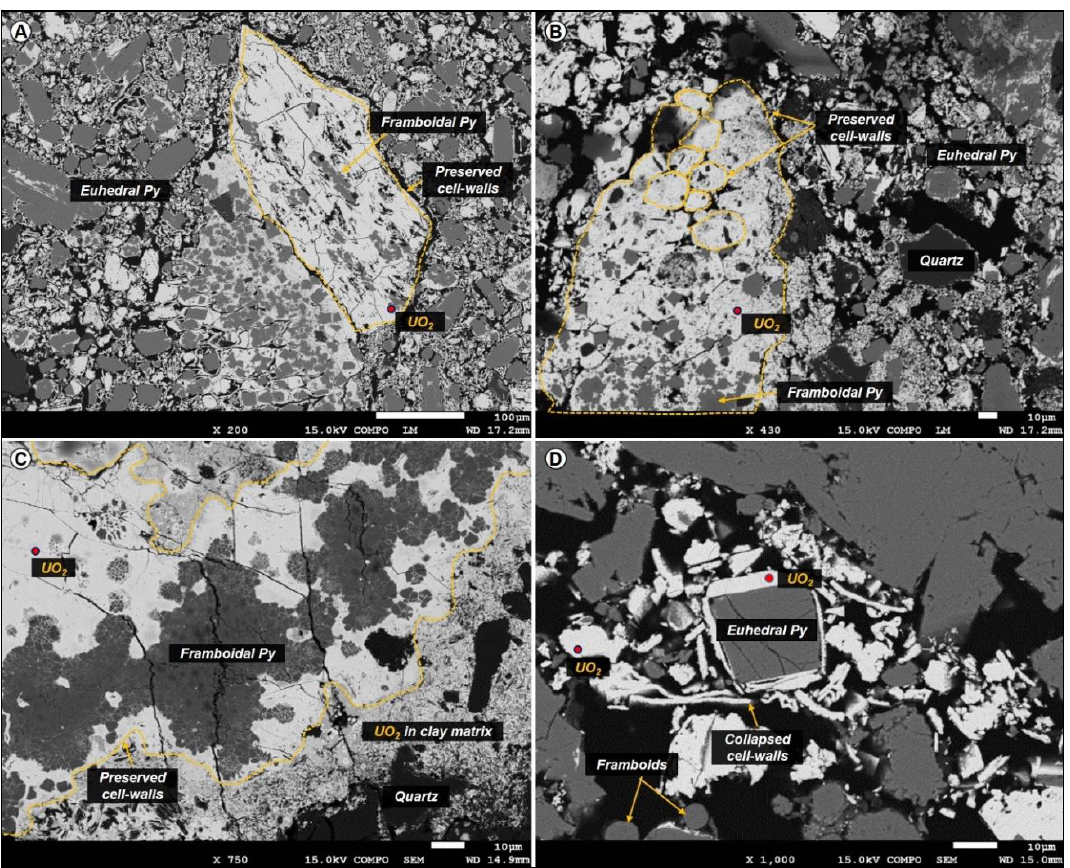
Figure 13. Examples of organic matter replaced by uranium, which is expressed in oxide form at the rims of the organic particle with a composition close to UO 2 stoichiometry (as measured under SEM-EDS mode). ( A ) Telohuminite particle at a size range of 400 μm, with the textural characteristics (cell walls and desiccation cracks) still visible. ( B ) Elongated telohuminite particle composed of smaller epigenetized corpohuminite particles. ( C ) A fully uranium-cemented organic particle associated with framboidal pyrite showing features of corrosion and uranium replacement. The cell walls of the particle are preserved even after replacement. The particle is surrounded by U-rich clay matrix. ( D ) Collapsed cell wall structures (attrinite) surrounding a large euhedral pyrite crystal.